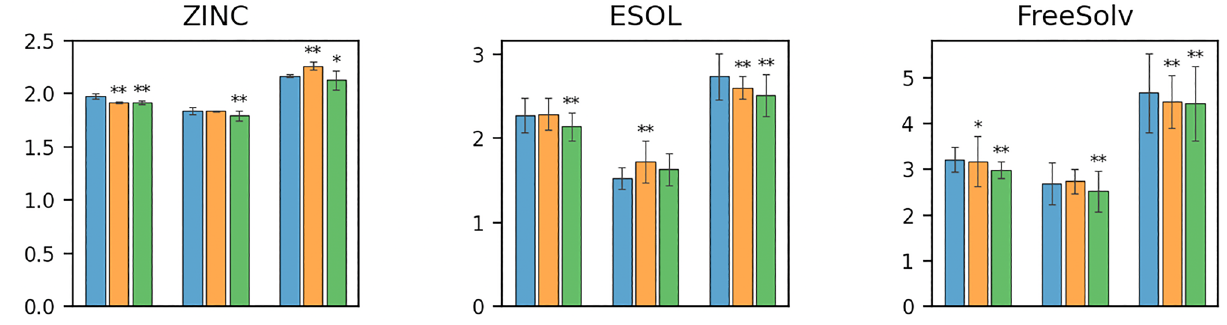
Figure 3. MAE comparison results of ZINC, ESOL, and FreeSolv. The x-axises correspond to the three simulated biased sampling scenarios (Scenario 3 was not performed on them). The blue, orange, and green bars correspond to the Baseline, IPS, and CFR approaches,